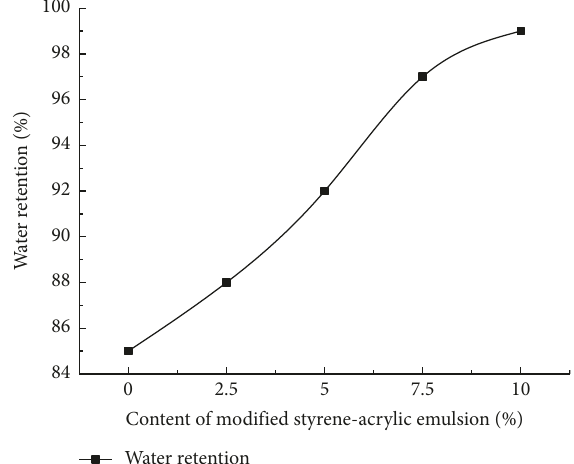
Figure 12: Influence of modified styrene-acrylic emulsion pa- rameters on the water retention rate of the cement slurry.